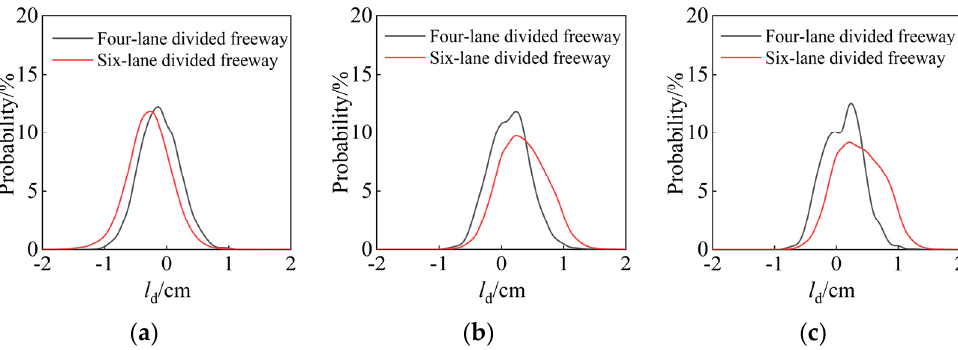
Figure 10. ( a ) Preferred trajectory distribution of the inner lane of cars; ( b ) preferred trajectory distribution of the outside lane; ( c ) preferred trajectory distribution of the outside lane of trucks.